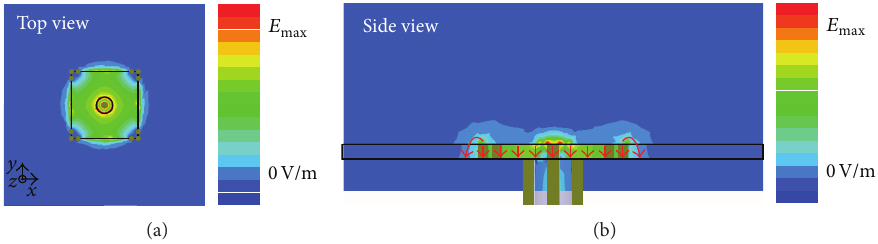
Figure 2: Instantaneous electric field distribution on resonance: (a) top view, (b) side view.